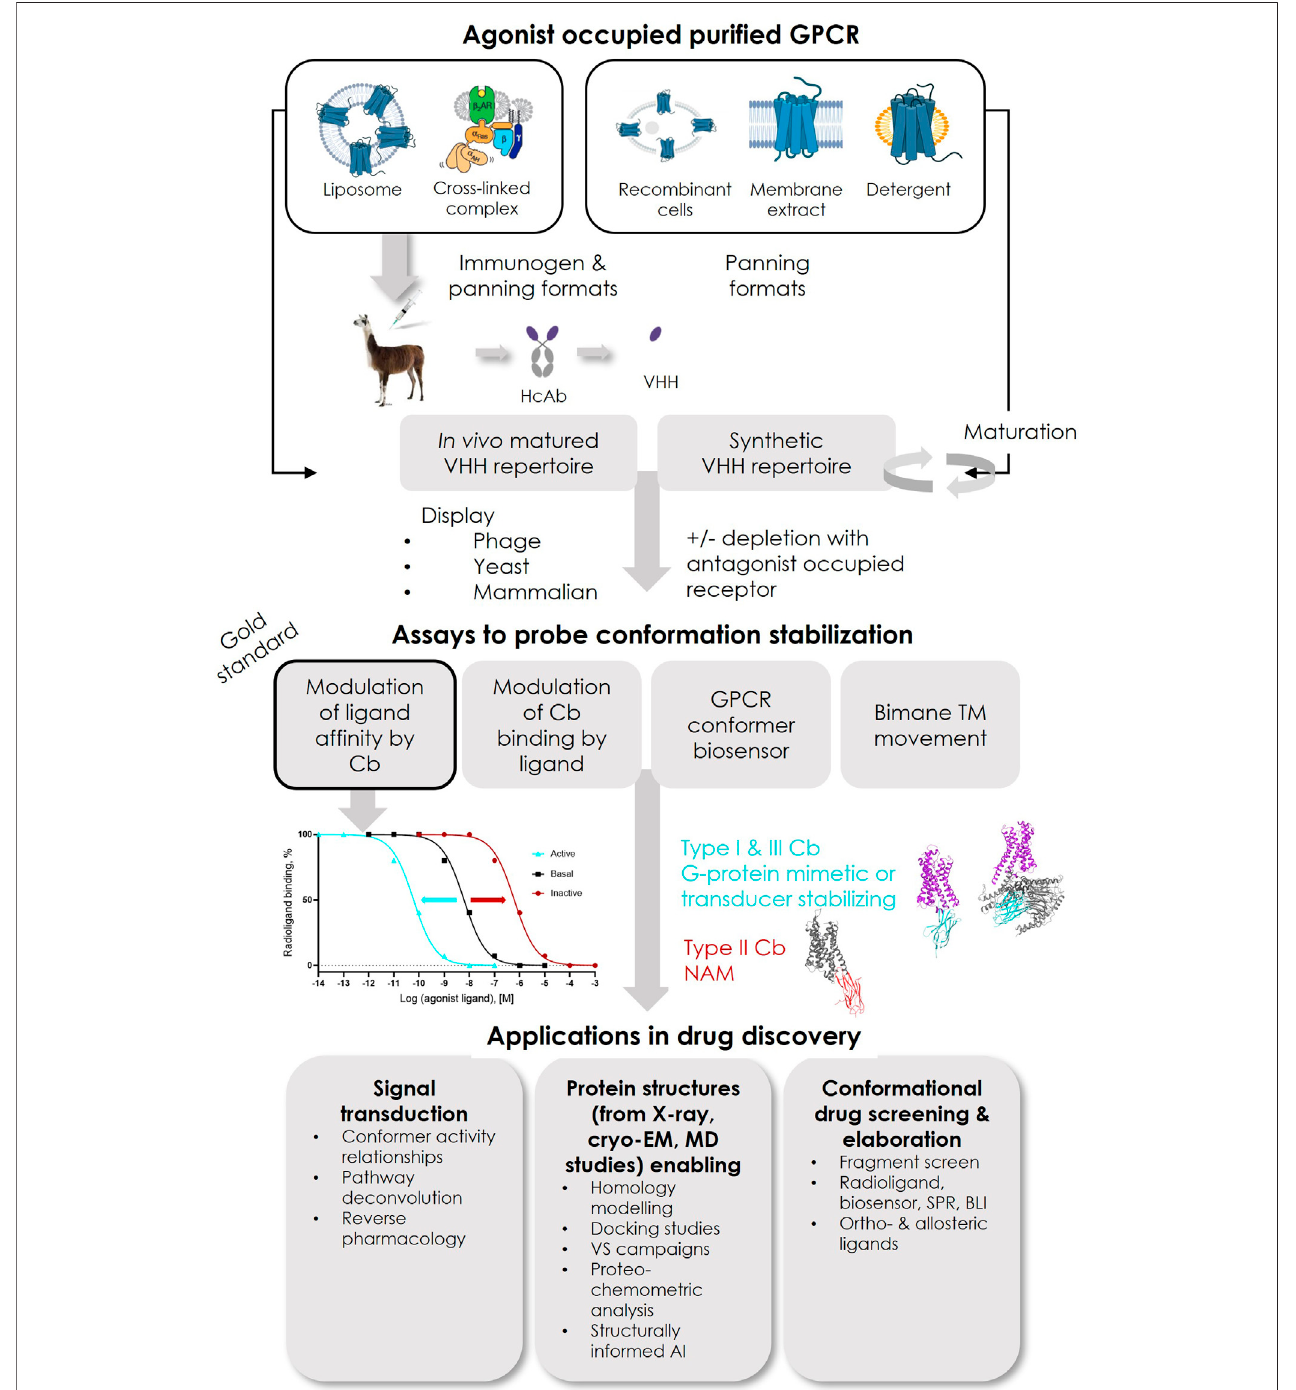
FIGURE 2 | Overview of reported successful Type I and Type III ConfoBody discovery strategies and applications of ConfoBodies in GPCR drug discovery. Immunogens that so far contributed to the identi fi cation of active state ConfoBodies are puri fi ed protein reconstituted in liposomes or a cross-linked complex. GPCR con fi gurations that have been successfully applied as panning formats in combination with the different display methods (phage, yeast, or mammalian display) are puri fi ed protein reconstituted in liposomes or as detergent micelle or a cross-linked complex with a downstream transducer or mammalian cells overexpressing recombinantreceptor(orderivedmembraneextracts).ThecombinationsofimmunogenandpanningformatsthatdeliveredCbscanbeextractedfrom Supplementary Table S1 . Abbreviations: arti fi cial intelligence (AI), biolayer interferometry (BLI), molecular dynamics (MD), surface plasmon resonance (SPR), virtual screening (VS).